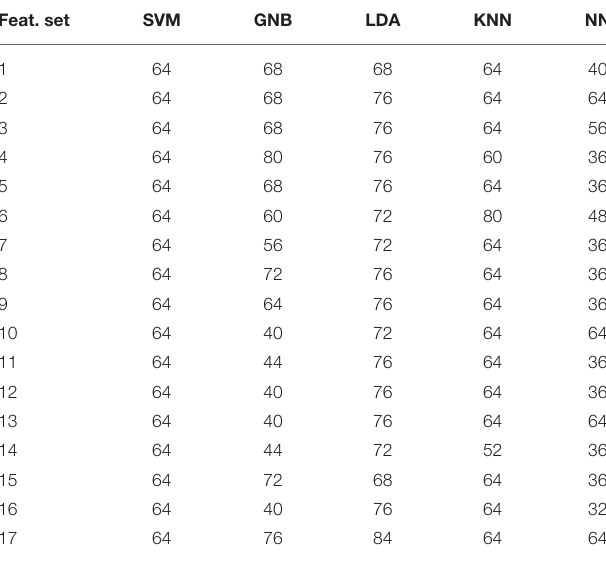
TABLE 6 | Performance of different models at different extracted features for speech (S) modality obtained from AC channel. Feat. set